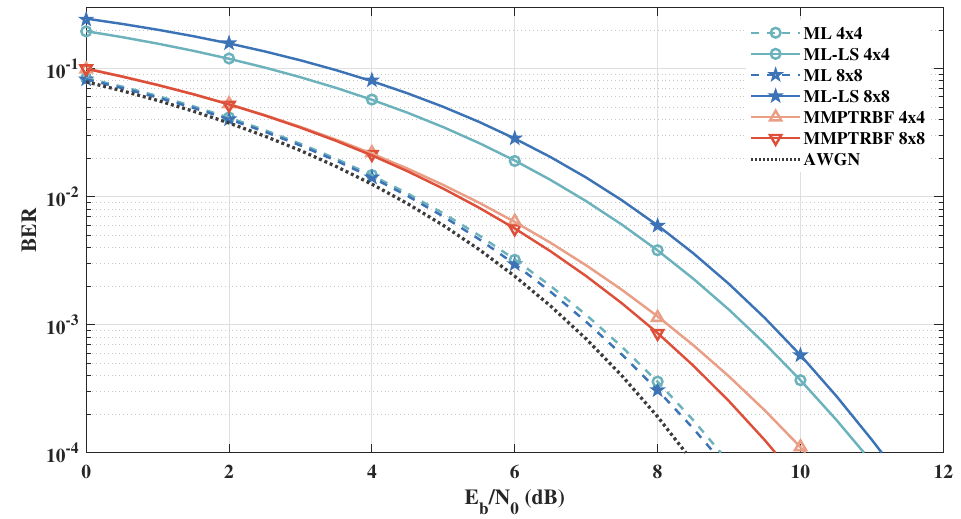
Figure 19. Systems with M T = M R = 4, M T = M R = 8 antennas for 4-QAM